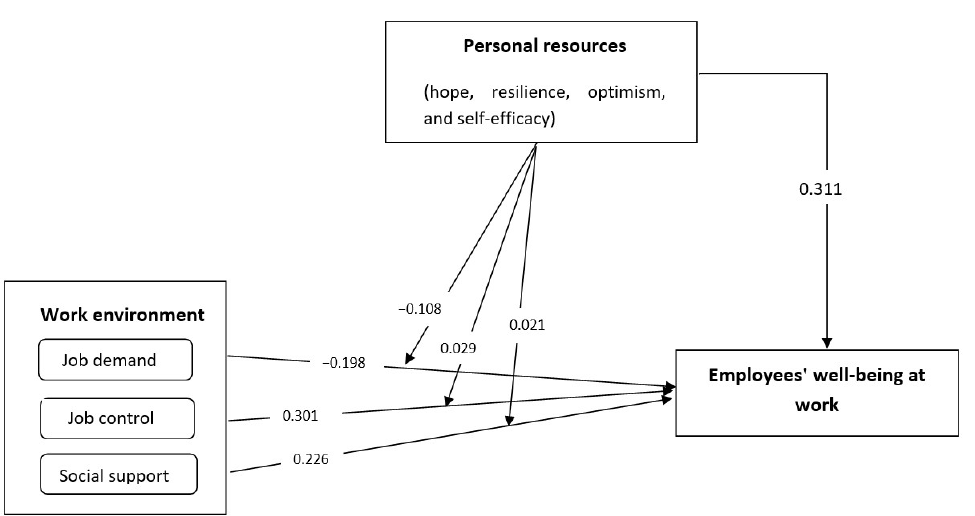
Figure 1. The results of the path model are based on standardized regression